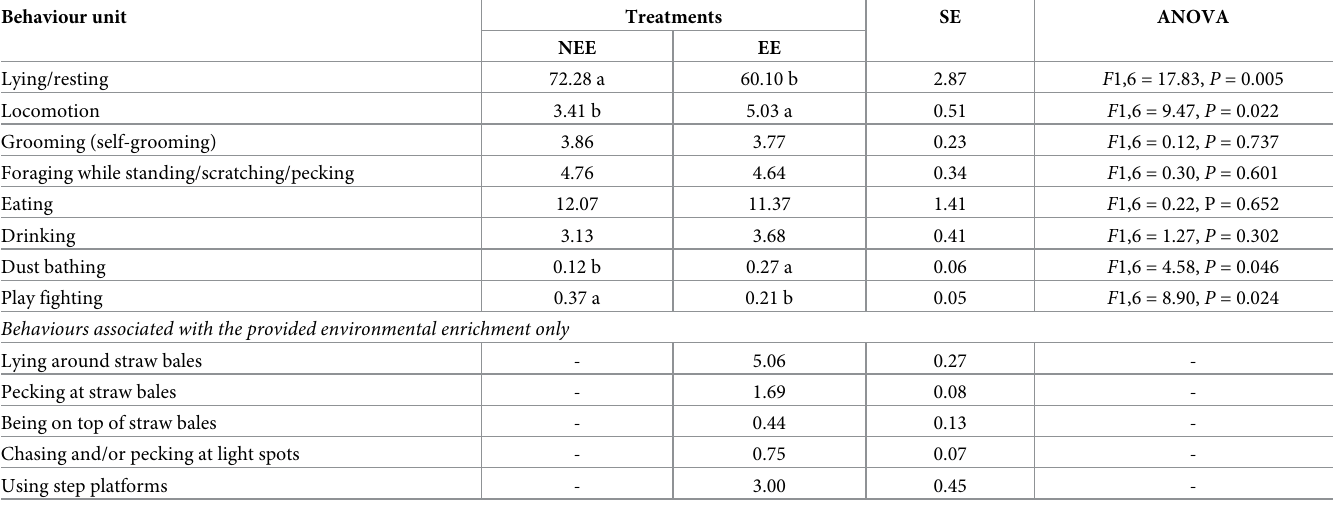
Table 2. Frequency (%) of each behaviour observed for broiler chickens as effects of the treatments. Behaviour unit